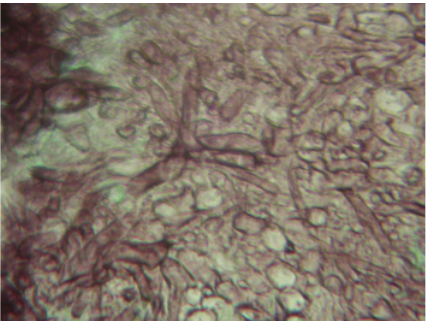
Figure 1: Aseptate hyphae with wide branching angles and large diameter from a lung fungus ball suggestive of mucormycosis (GMS stain 400 ×